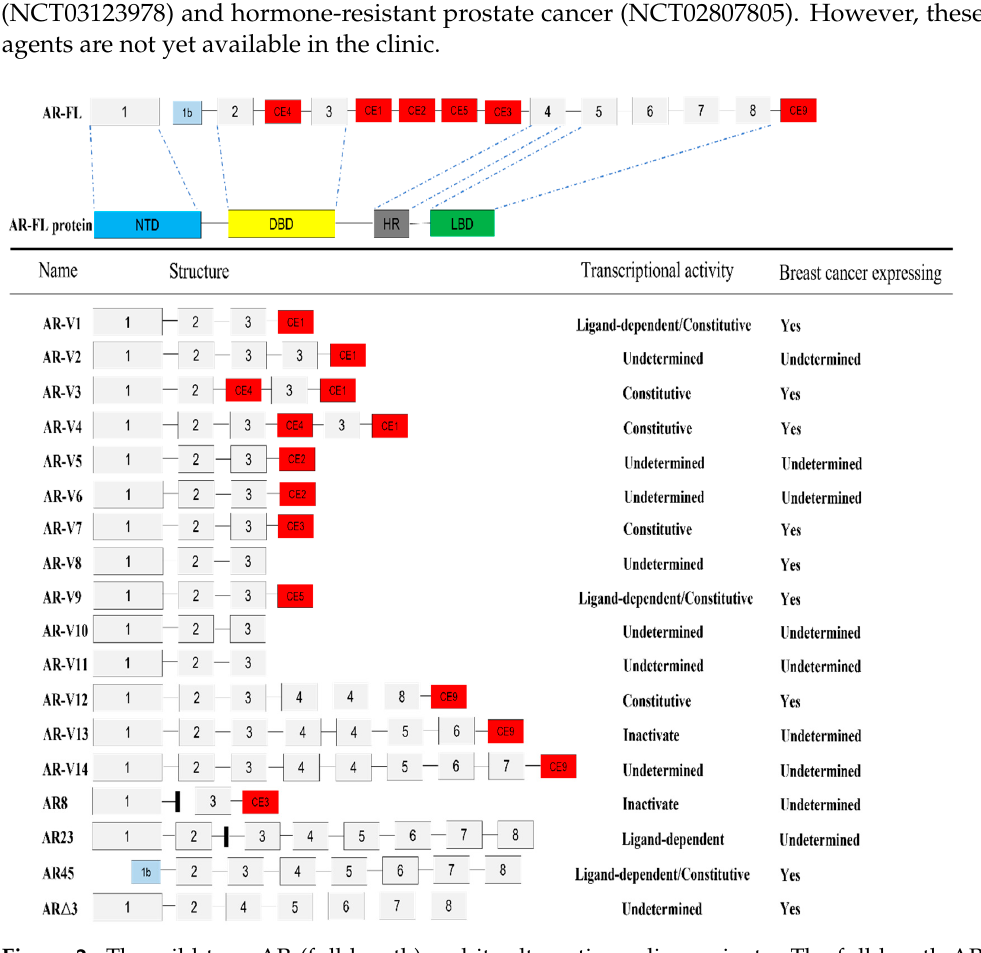
Figure 2. The wild-type AR (full-length) and its alternative splice variants. The full-length AR (AR-FL) gene harbors eight canonical exons, exons 1–8 and seven cryptic exons (CEs), 1b, CE1-5 and CE9. Dif- ferent transcriptional manners of the gene generate AR-FL and at least eighteen AR-Vs, including AR- V1 [89], AR-V2 [90], AR-V3 [90], AR-V4 [89], AR-V5 [90], AR-V6 [90], AR-V7 [89], AR-V8 [91], AR-V9 [91], AR-V10 [91], AR-V11 [91], AR-V12 [92], AR-V13 [92], AR-V14 [92], AR8 [93], AR23 [94], AR45 [95] and AR Δ 3 [96]. Among them, AR-V5 and AR-V6 have similar structures but differ by an 80 bp contig- uous 5 ′ extension in the CE2 of AR-V5 [90]; AR-V8, AR-V10 and AR-V11 also have similar structures but differ by their downstream 3 ′ sequence with the proteins truncated after exon 3 with 10–39 amino acids extension before the stop codon [91]. AR8 and AR23 contain a unique sequence (presented by a small black square in the figure) with 23 amino acids inserted in the DBD [93,94].